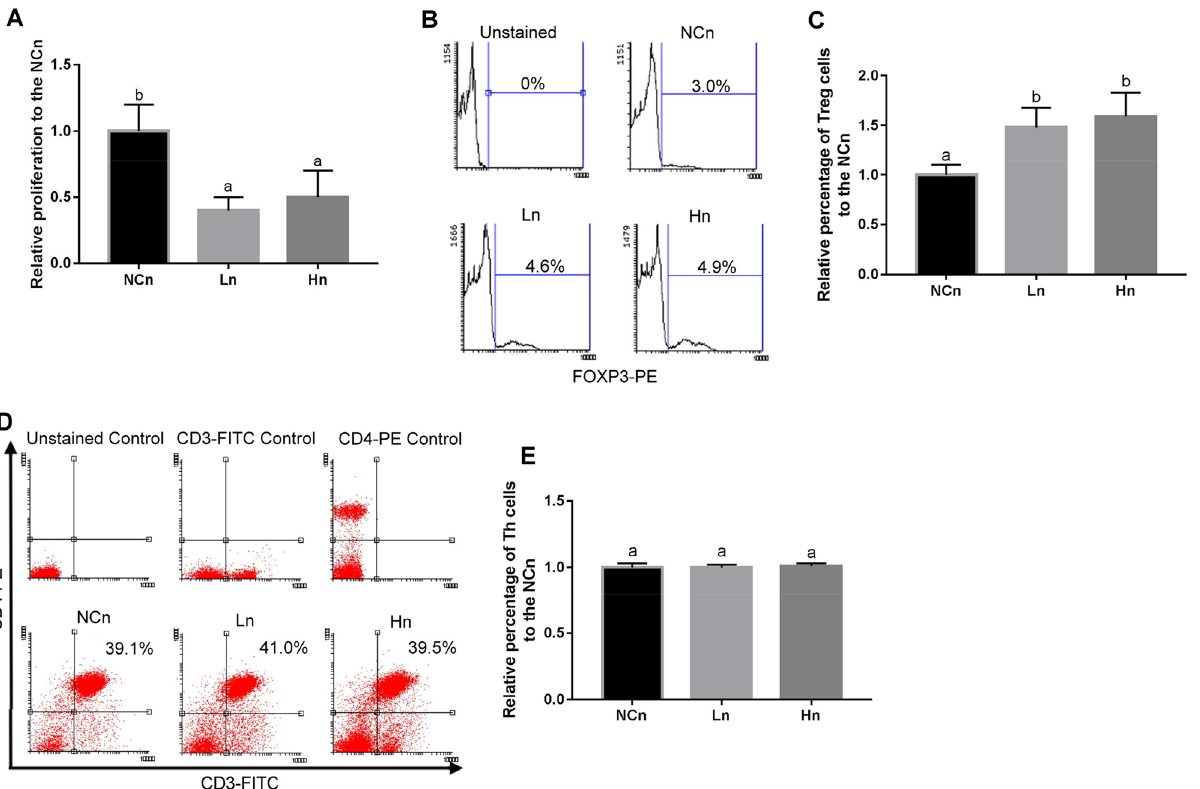
Figure 4. Effects of LcSFB on splenocytes from OVA-injected (s.c.) mice with additional intranasal administration ex vivo. ( A ) Proliferation of splenocytes. ( B ) Representative experiments evaluating the effect of LcSFB on Treg cells. ( C ) Relative percentage of Treg cells in the splenocytes. ( D ) Representative experiments evaluating the effect of LcSFB on T helper cells. ( E ) Relative percentage of T helper cells in splenocytes. NCn mice gavaged with saline, negative control, Ln mice gavaged with low-dose LcSFB, Hn mice gavaged with high- dose LcSFB. Different superscript letters (a, b) indicate significant differences at p < 0.05; one-way ANOVA with Tukey HSD post-hoc tests ( n =